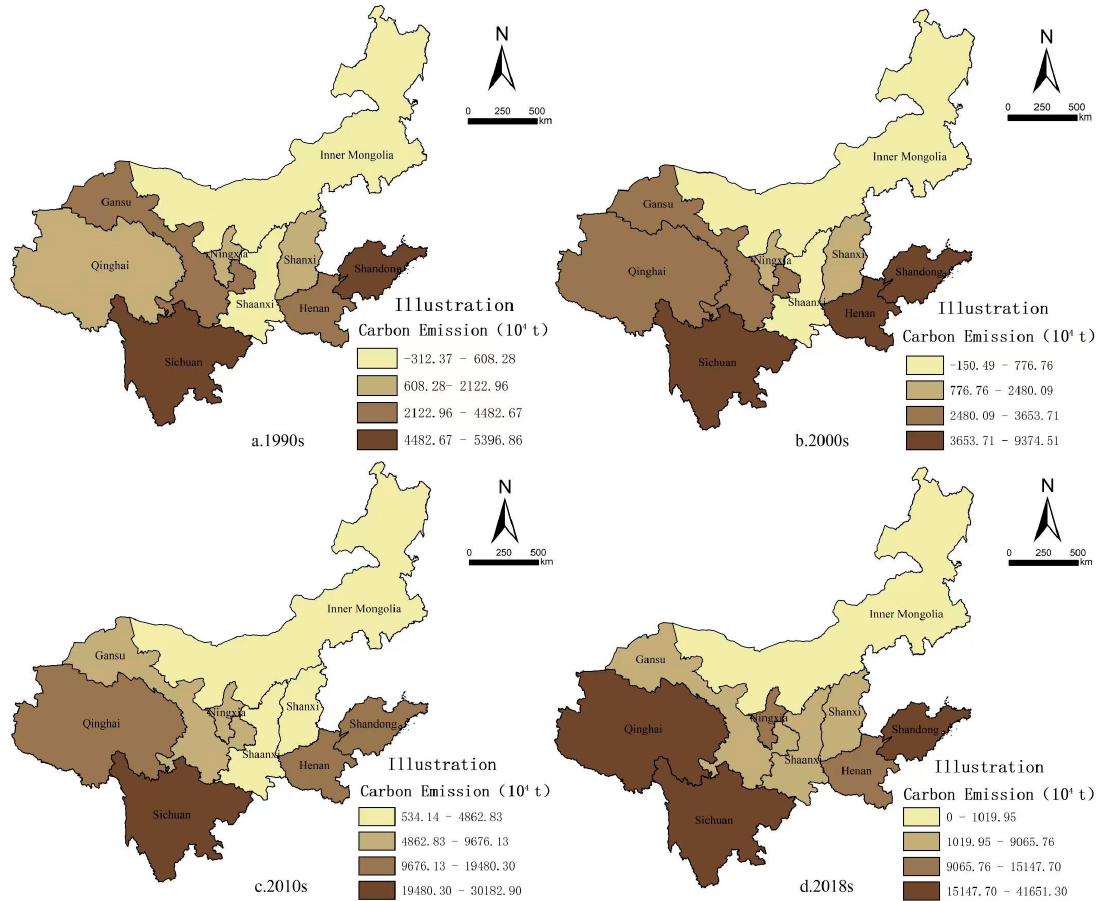
Figure 2. Spatial distribution of net carbon emissions by province in the study area by year (10 4 t). Overall, the carbon emissions in the Yellow River Basin are high. There were signifi- cant differences in carbon emissions among the nine provinces (regions) along the Yellow River, with four provinces (Shanxi, Shaanxi, Henan, and Shandong) in the middle and lower reaches of the Yellow River belonging to the high emission area, two provinces (re- gions) in Sichuan and Inner Mongolia in the upper reaches of the Yellow River belonging to the medium emission area, and three provinces (regions) in Qinghai, Ningxia, and Gansu belonging to the low emission area, with large differences in the spatial distribution of carbon emissions (Figure 2). In 1990, Sichuan Province and Shandong Province were the main carbon emitter areas, with a total net carbon emissions of 107,278,100 tons, ac- counting for 43% of the total carbon emissions of the nine provinces (regions). In 2000, the proportion of carbon emissions in Henan Province increased, which was considered the top carbon emitter area together with Sichuan Province and Shandong Province, with a total carbon emissions of 225,969,700 tons in these three provinces and regions accounting for 64% of the total net carbon emissions of the study area. The net carbon emissions in 2010 were mainly concentrated in Sichuan Province, with a total of 301,829,000 tons, ac- counting for 28% of the total net carbon emissions of the study region; however, the re- gional net carbon emissions in 2018 were mainly concentrated in Qinghai Province, Si- chuan Province, and Shandong Province, with a total net carbon emissions of 1025.407 million tons, accounting for 65% of the total regional carbon emissions. Sichuan Province had the largest carbon emissions in all four periods from 1990 to 2018, whereas Inner Mon- golia had the smallest carbon emissions. Overall, the low carbon emission areas were mainly distributed in the central and northern parts of the Yellow River Basin, namely, the Inner Mongolia Autonomous Region and the Shaanxi District, which are dominated by mountains and grasslands, with high forest cover areas and large carbon sinks but relatively low amounts of total carbon emissions [42]. The high carbon emission areas, however, were concentrated in the southern and eastern parts of the Yellow River Basin,